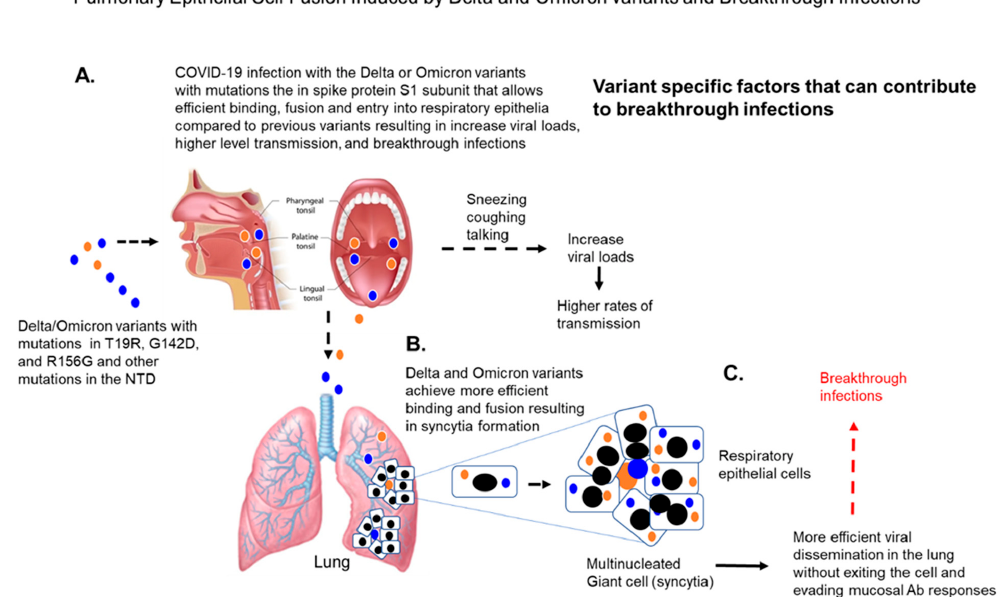
Figure 4. COVID-19 infections: both the Delta and Omicron variants have mutations in the N-terminal domain that can contribute to their transmission and dissemination resulting high viral loads ( A ). The Delta and Omicron variants under certain conditions can cause cell-to-cell fusion of respiratory epithelial cells resulting in syncytia formation ( B ). These syncytia or multinucleated giant cells can release infection virus to infect neighboring cells without exiting the cell, thereby evading mucosal antibody responses that could contribute to breakthrough infections ( C ).